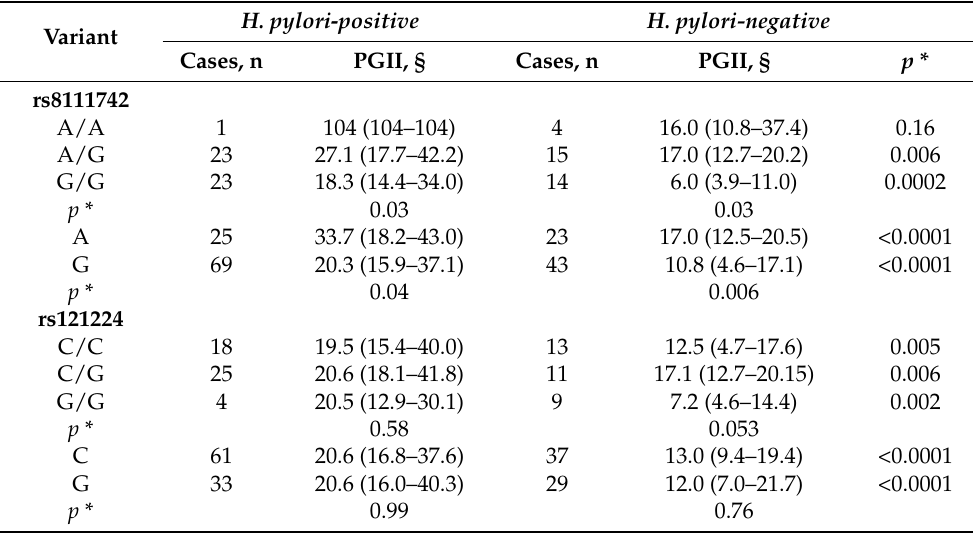
Table 10. Effect of genotype and allele on PGII levels in 80 patients with gastric cancer (GC) based on anti- H. pylori